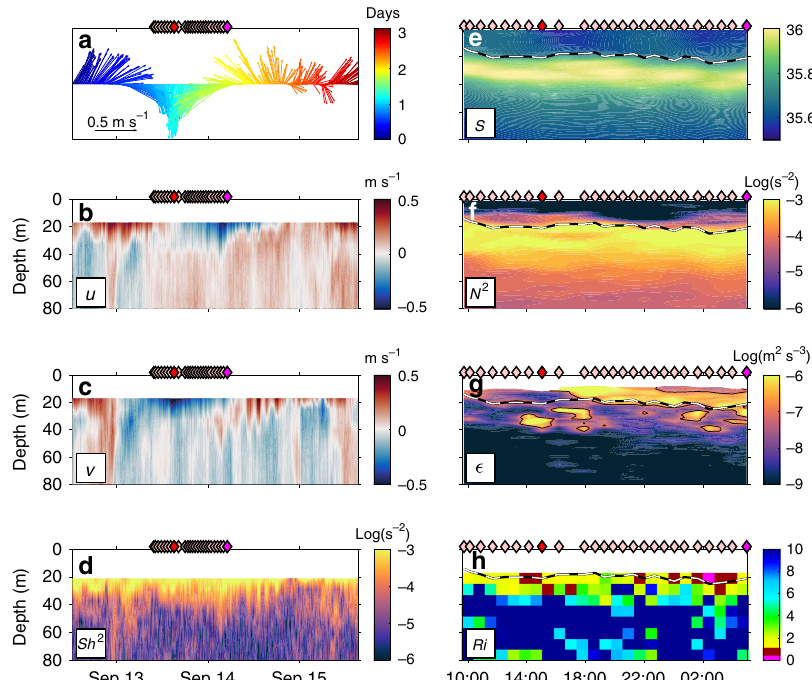
Fig. 3 Near inertial wave event near 11.5°N, 23°W during September 2015. Data from the vessel-mounted acoustic Doppler current pro fi ler (vmADCP) from top to bottom: a current vectors from the fi rst vmADCP bin (13 – 21 m depth), b zonal velocity ( u ), c meridional velocity ( v ), and d squared vertical shear of horizontal velocities ( Sh 2 ). Microstructure pro fi ler observations acquired between September 13, 10:00 UTC and September 14, 06:00 UTC, from top to bottom: e salinity ( S ) , f squared buoyancy frequency ( N 2 ), g dissipation rates of turbulent kinetic energy ( ε ), and h 8m- Ri number ( Ri ). On all panels times of microstructure pro fi les are indicated with light red diamonds, whereas two speci fi c pro fi les are highlighted in red/magenta and shown in detail in Fig. 4. Color-coding in a corresponds to time after fi rst considered vmADCP observation for better visibility of the individual current vectors. Black and white dashed line in e – h denotes the mixed layer depth.